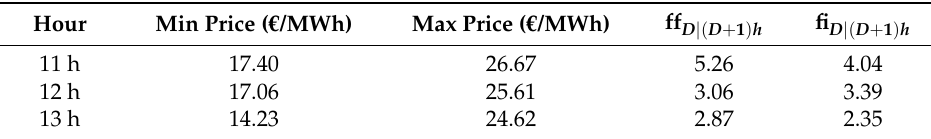
Table 3. Results of PPFMCP model 2.